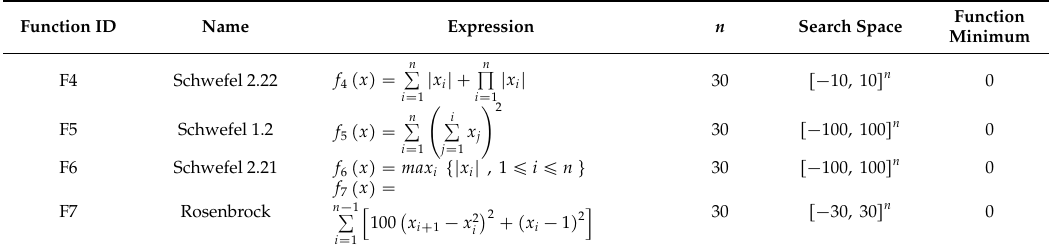
Table 5. Unimodal and non-separable test functions.